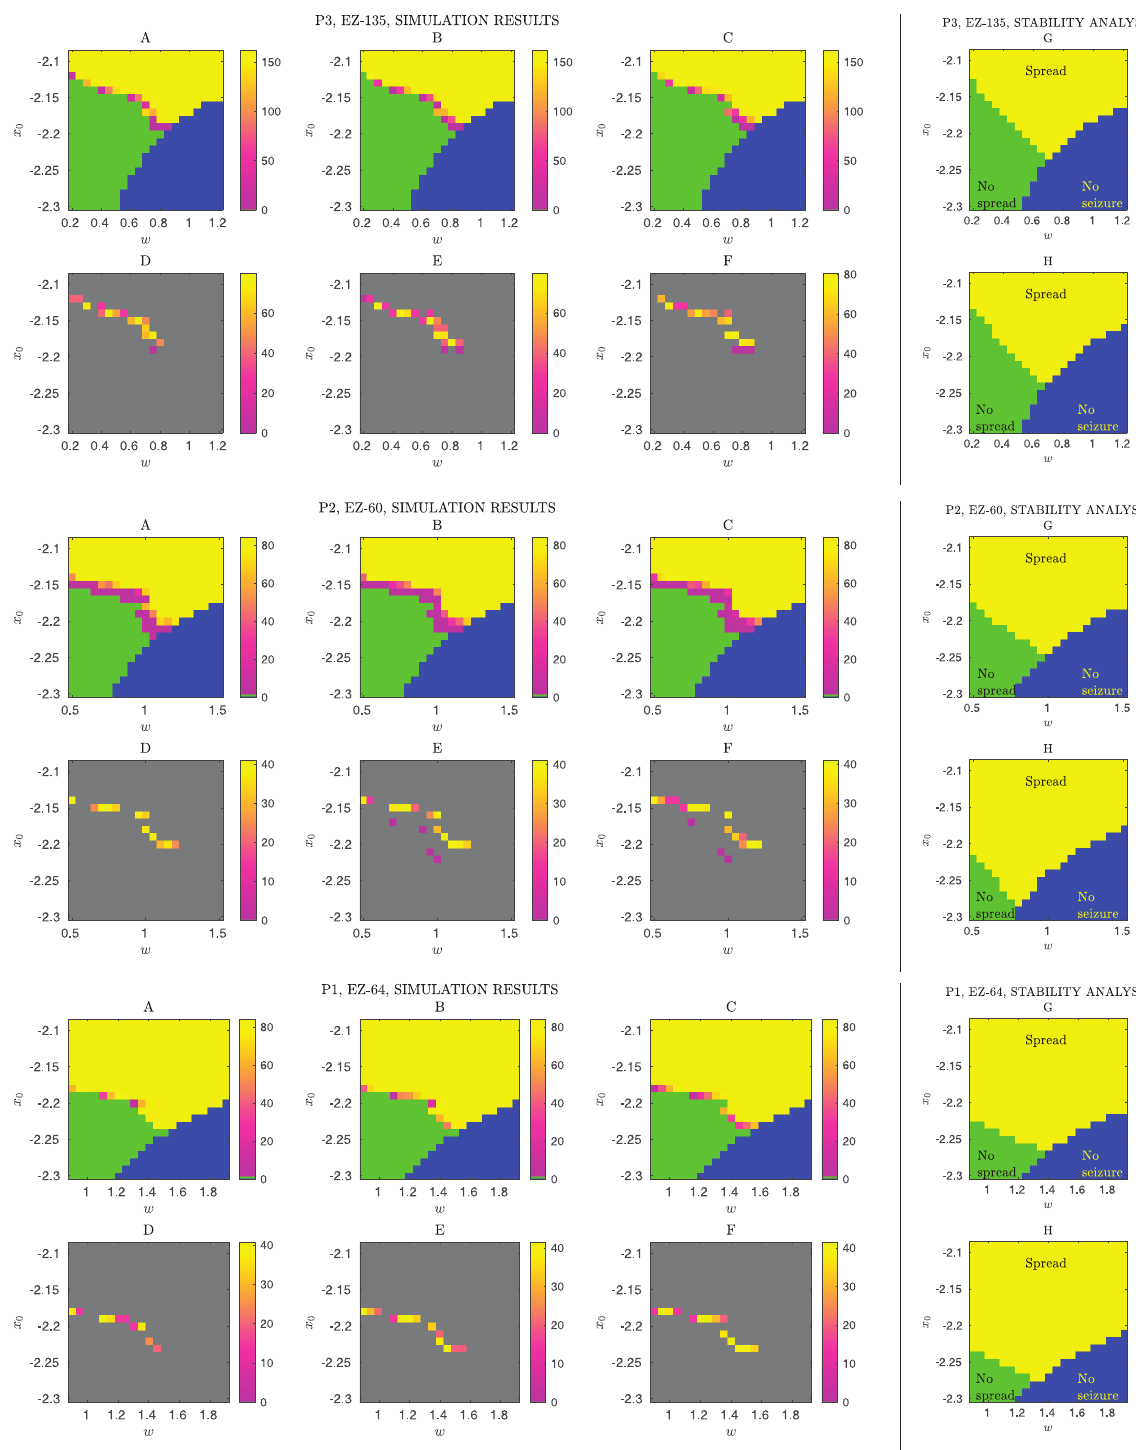
Fig 2. Seizure-spread phase diagrams. Seizure spread is examined as a collective state variable, i.e. spread size or number of seizing nodes, under variations of global connectivity strength ( w ) and homogeneous surrounding node excitability ( x 0 ). Top (A,B,C) The phase diagrams were obtained by simulating the epileptor network (patient P3, node 135 corresponds to the active EZ, with x 0 = − 1.6) for three different noise strengths ( σ = 0.05, σ = 0.10, σ = 0.15). Blue, green and yellow colors represent no seizure, no spread and seizure spread, respectively, obtained from 30 realizations of the stochastic dynamics for a given parameter setting (each point in the diagram). The colorbar indicates spread size. (D,